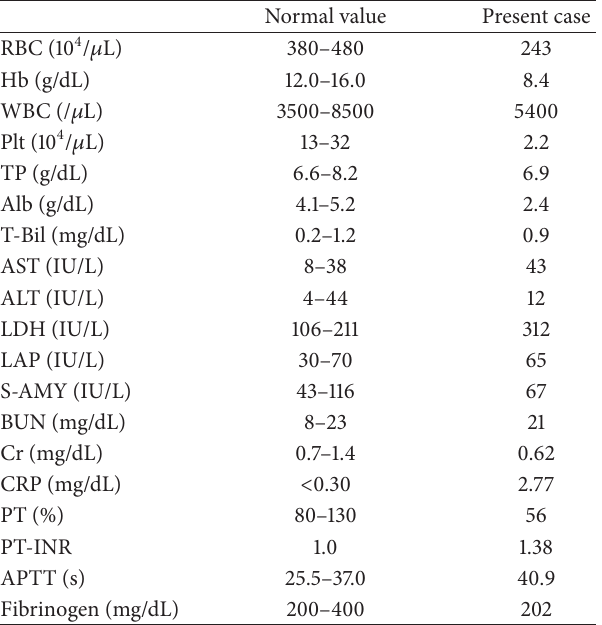
Table 1: Laboratory data on admission. Normal value Present case